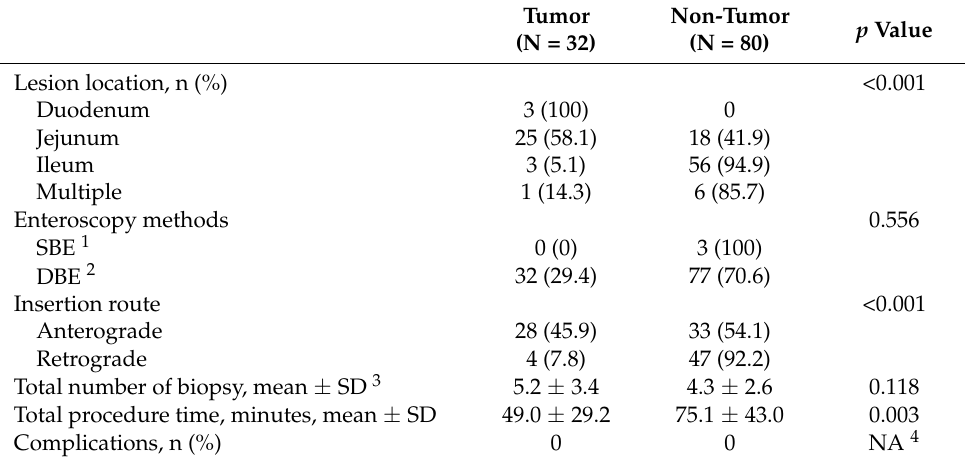
Table 2. Technical characteristics of device-assisted enteroscopy and biopsy in tumor and non- tumor groups.